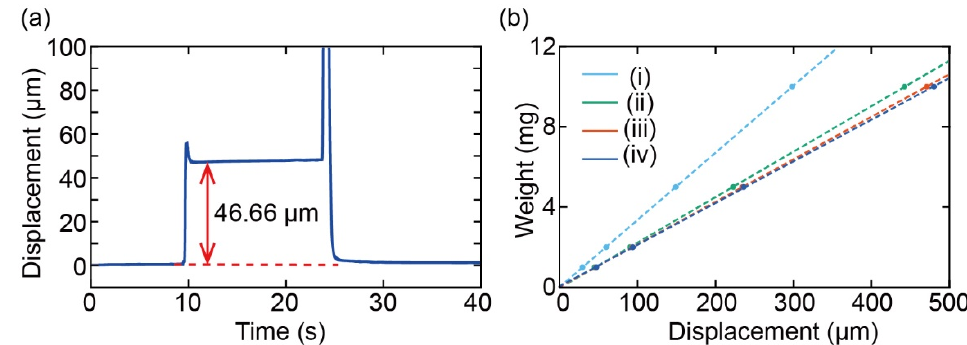
Figure 9. ( a ) Displacement output of the calibration and ( b ) relationship between weight and dis- placement.